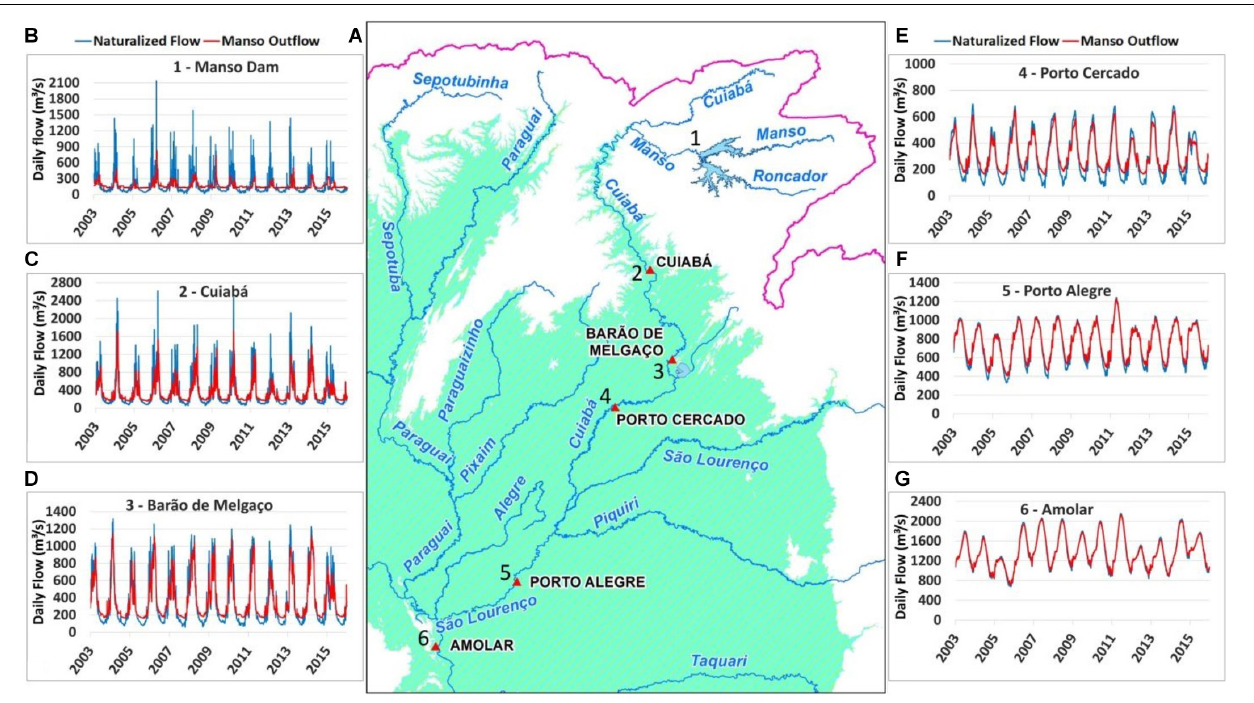
FIGURE 3 | Location (A) of the hydrographs produced after simulation with naturalized flow (blue) and Manso outflow (red) as input condition at: Manso dam (B) , Cuiabá gauge (C) , Barão de Melgaço gauge (D) , Porto Cercado gauge (E) , Porto Alegre gauge (F) , and Amolar gauge (G)